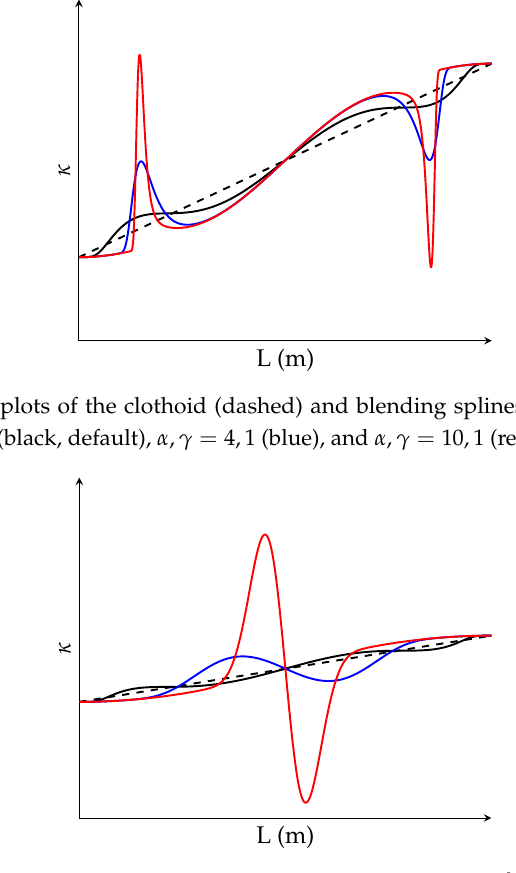
L (m) Figure 20. Curvature plots of the clothoid (dashed) and blending splines in [ p 1 , q 1 ] for slope parameters Figure 19. Curvature plots of the clothoid Figure 20. Curvature plots of the clothoid β = 1.0 (black, default), β = 8.0 (blue), and β = 50.0 (dashed) and blending splines in [ p 1 , q 1 ] for (dashed) and blending splines in [ p 1 , q 1 ] for tightening parameters α , γ = 1,1 (black, slope parameters β = 1.0 (black, default), Figure 21. Curvature plots of the clothoid β = 8.0 (blue), and β = 50.0 (red). default), α , γ = 4,1 (blue), and α , γ = 10,1 (dashed) and blending splines in [ p 1 , q 1 ] for (red). balance parameters λ = 0.5 (black, default), λ = 0.2 (blue), and λ = 0.8 (red).